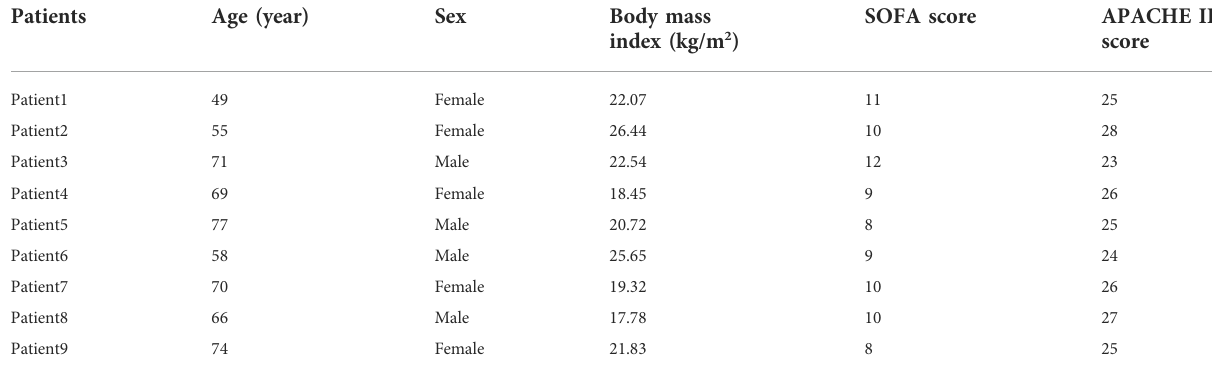
TABLE 2 Detailed clinical information of 9 sepsis